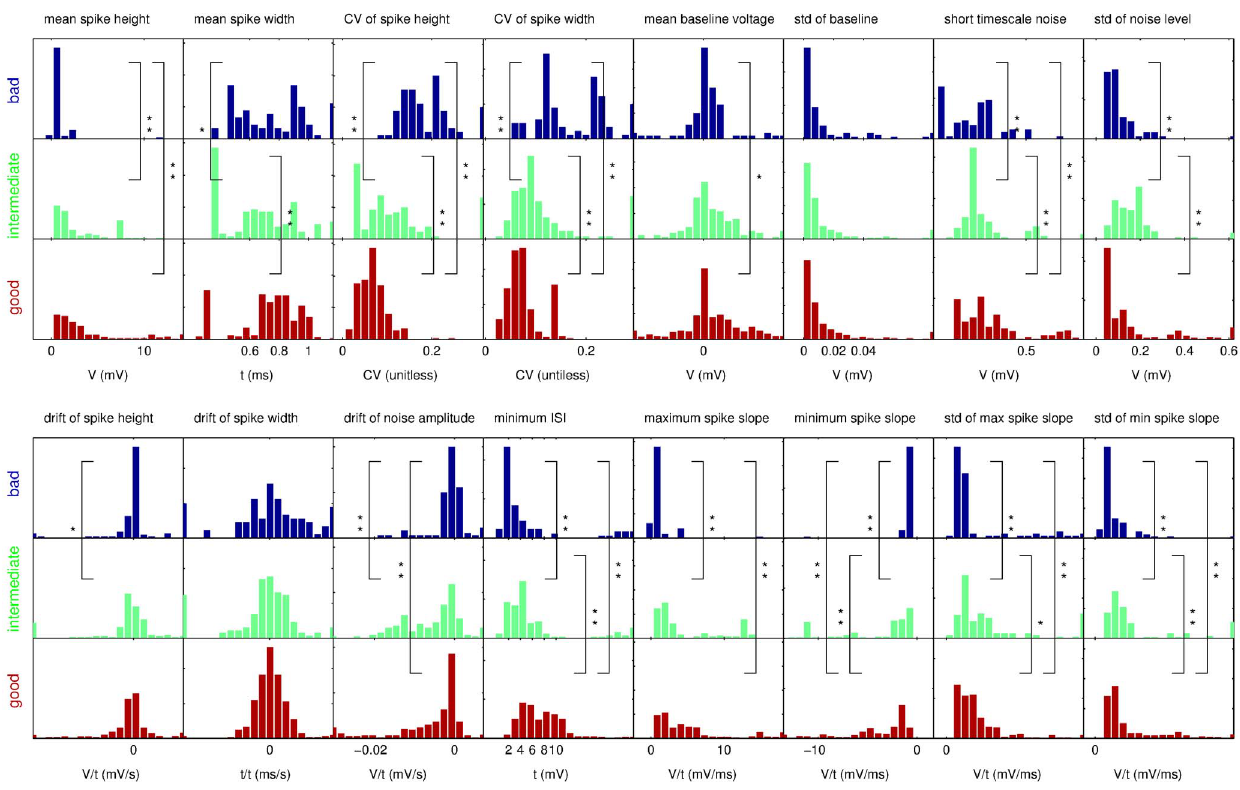
Figure 3. Overview of the observed distributions of feature values for data set 2. The conventions are as in Figure 3. We note that for this data set the differences of feature value distributions are even more pronounced.